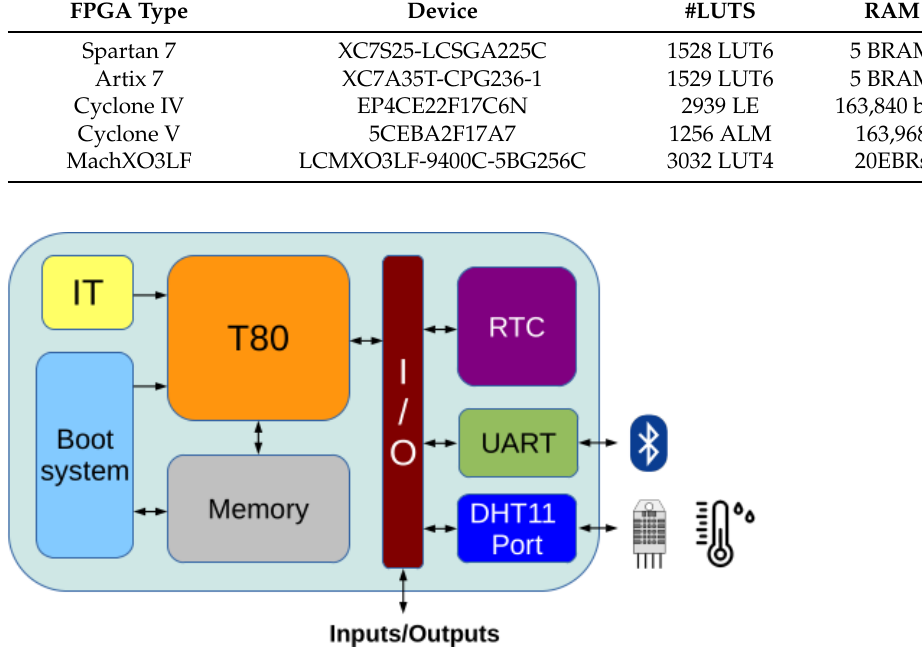
Figure 10. Minimal Dracon extended with Bluetooth wireless connectivity and digital humid- ity/temperature sensor.